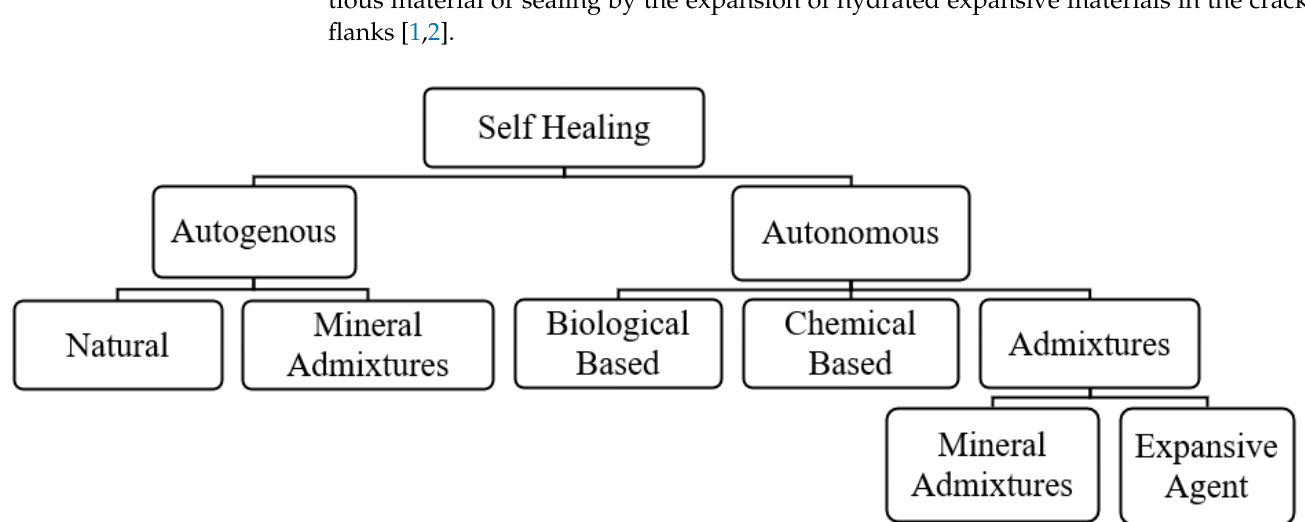
Figure 1. Self-healing mechanisms categorization.